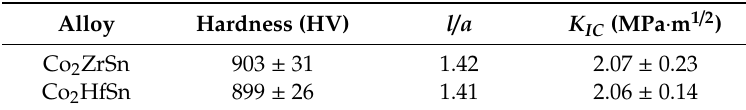
Table 2. Average values of l / a ratios, Vickers hardness, and fracture toughness K IC for the Co 2 ZrSn and Co 2 HfSn